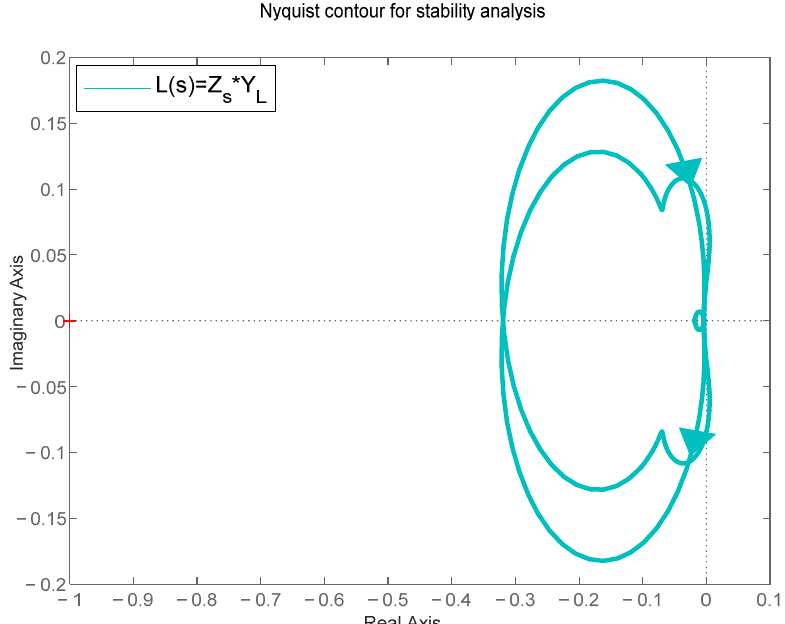
Figure 13. Stability analysis via Nyquist diagram.